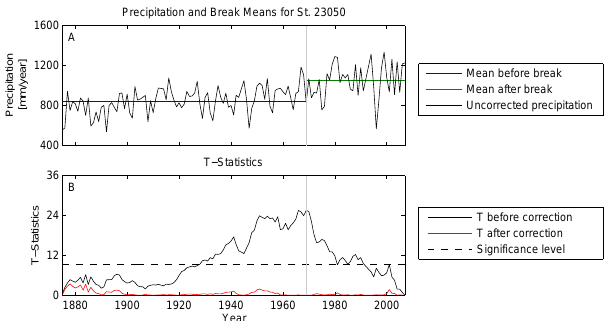
Fig. 2. (A) Uncorrected precipitation from station 23050, with lo- cation of break points marked as vertical grey lines. (B) T-statistics from the SNHT test before and after correction of the located break